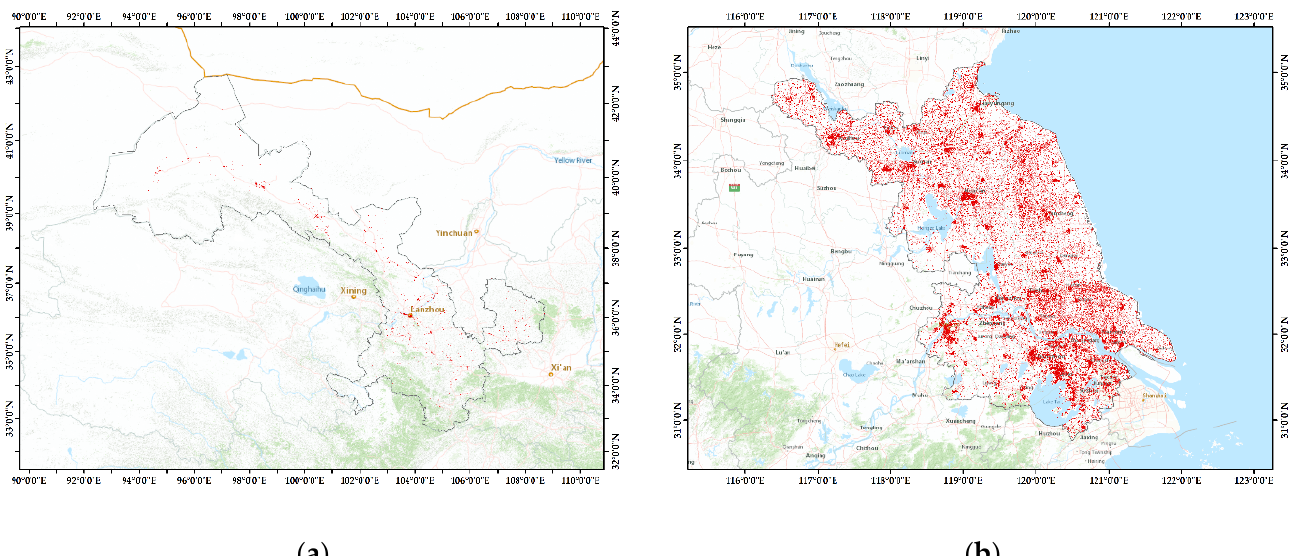
Figure 10. The BA results of the two provinces in 2020: ( a ) Gansu and ( b ) Jiangsu.